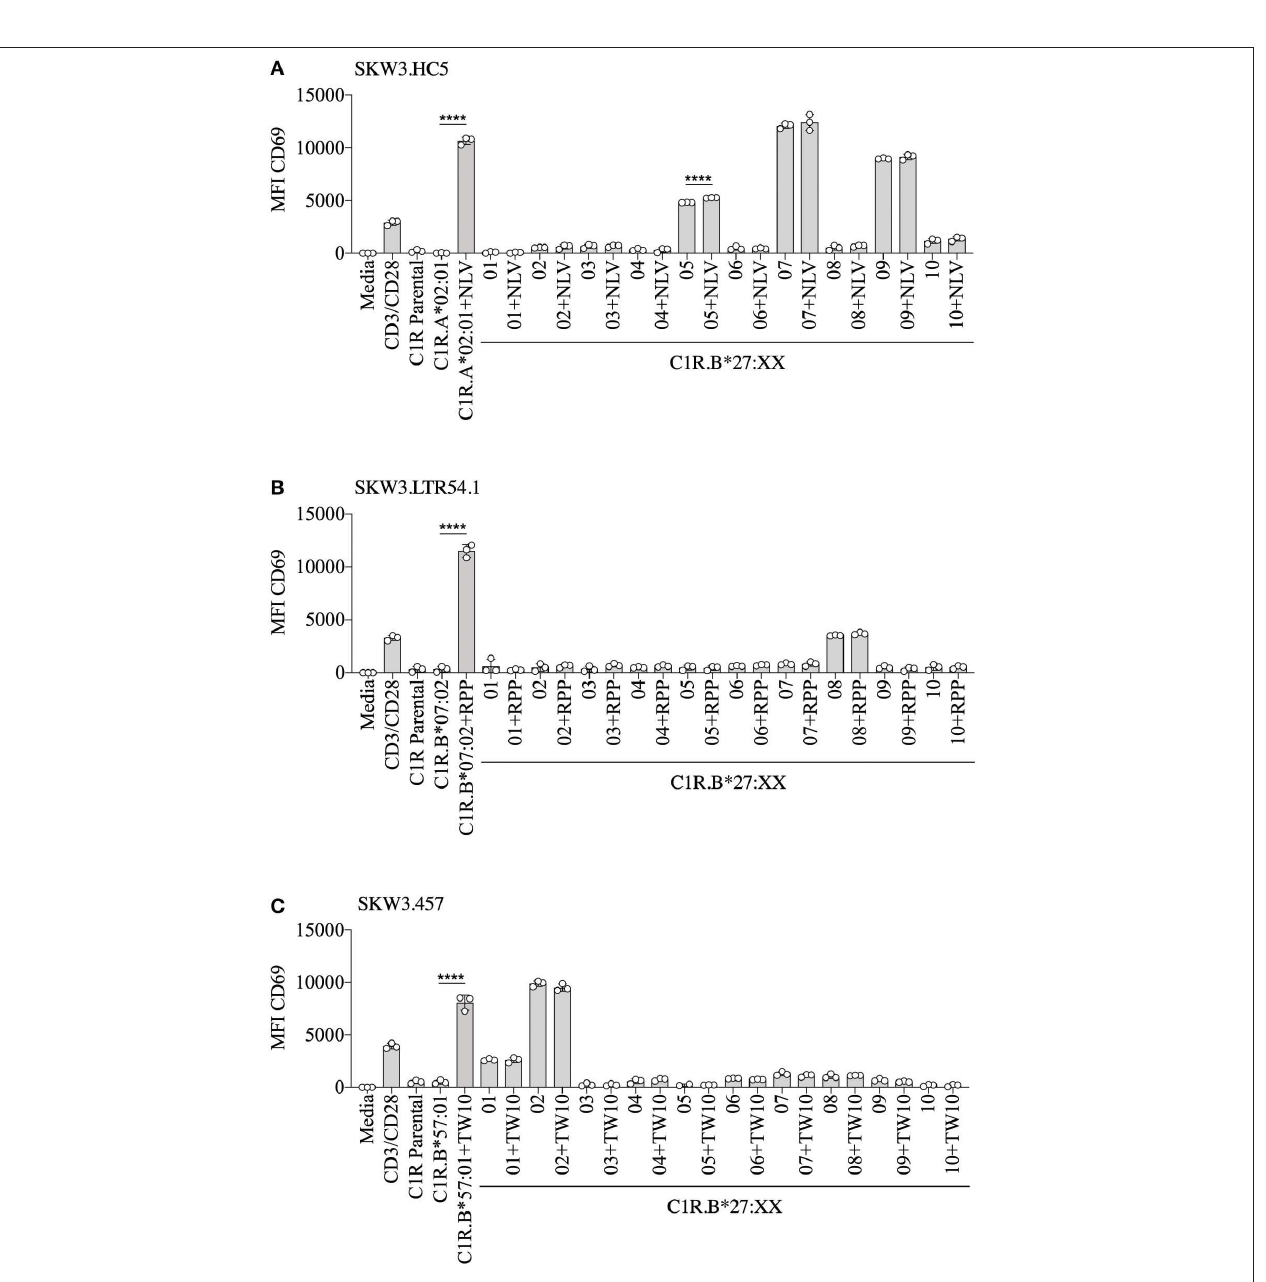
a T cell clone raised against CMV B7 RPHERNGFTVL with TCR V β 7.2 recognized DRB1 ∗ 08:01, whilst another T cell clone